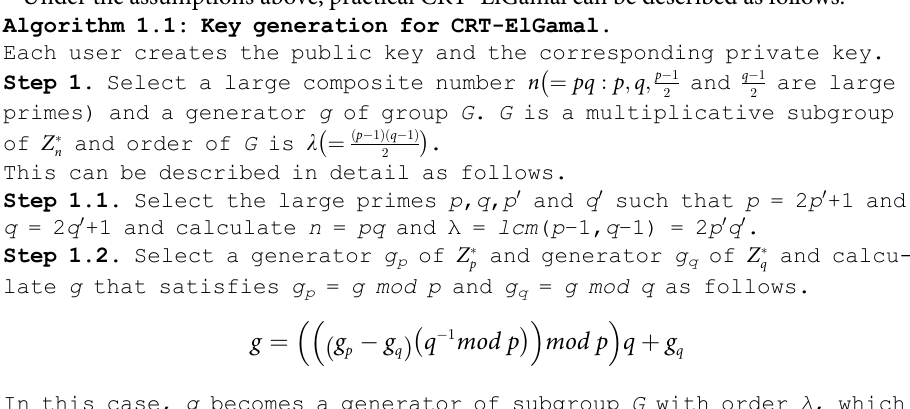
Algorithm 1.1: Key generation for CRT-ElGamal .